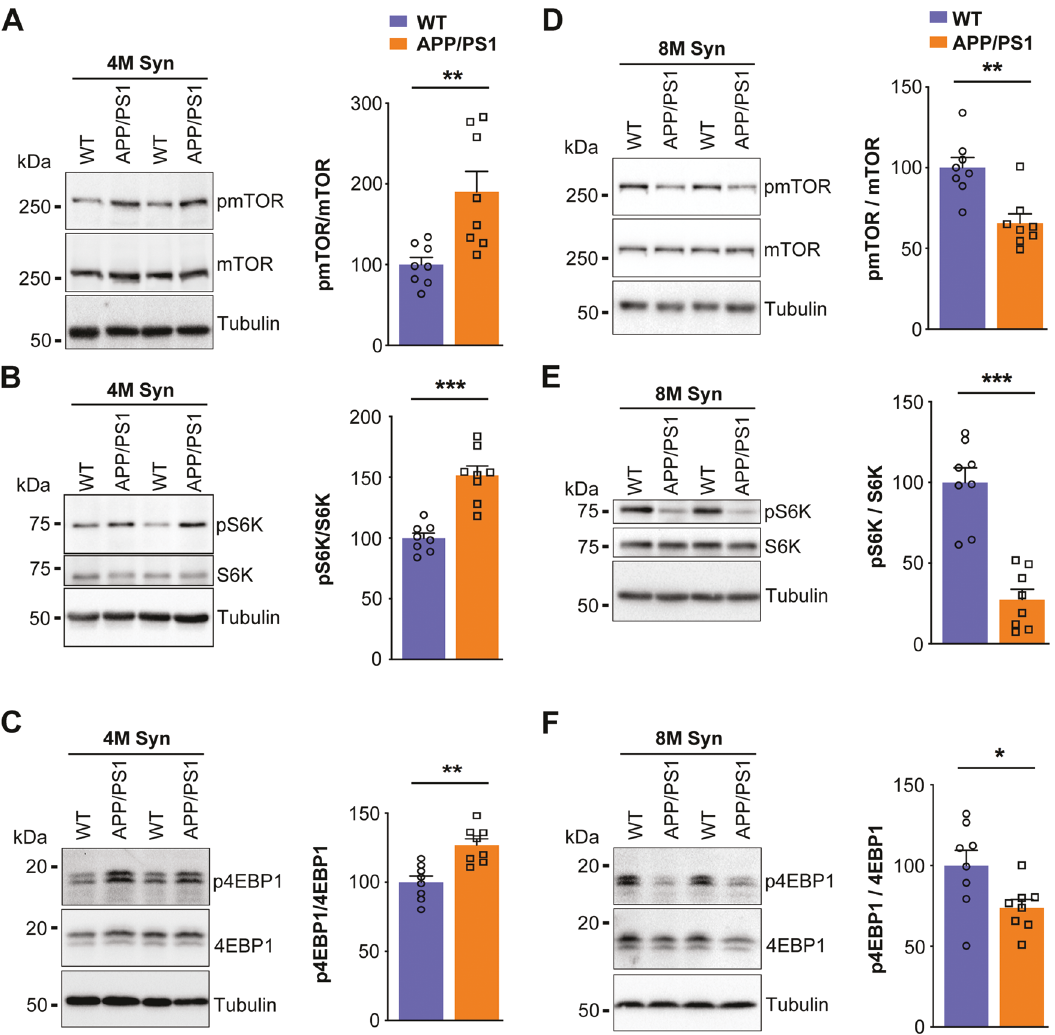
Fig. 4 Phosphorylation of mTOR, p70S6K, and 4E-BP1 is increased in synaptosomes of APP/PS1 female mice at 4 months of age but decreased at 8 months of age. Synaptosomes from the mouse brain cortex of 4 ( A – C ) and 8 ( D – F ) months old WT and APP/PS1 female mice were subjected to western blot analysis for ( A and D ) phospho-mTOR (serine-2448) antibody, ( B and E ) phospho-p70S6K (threonine-389) antibody, and ( C and F ) phospho-4E-BP1 (threonine-37/46). Later, these blots were stripped and reprobed, sequentially, for mTOR, p70S6K, 4E- BP1, and tubulin, respectively. A and D The data were quanti fi ed by measuring phosphorylated mTOR/mTOR (( A ) t = 3.367; df = 14; p = 0.0046; Hedges ’ g (95% CI) 1.59 (0.47, 2.66), ( D ) t = 4.059; df = 14; p = 0.0012; Hedges ’ g (95% CI) − 1.91 ( − 3.06, − 0.73)), ( B and E ) phosphorylated- p70S6K/p70S6K, (( B ) t = 5.908; df = 14; p < 0.0001; Hedges ’ g (95% CI) 2.79 (1.38, 4.15), (E) t = 6.757; df = 14; p < 0.0001; Hedges ’ g (95% CI) − 3.19 ( − 4.66, − 1.67)) and ( C and F ) phosphorylated-4E-BP1/4E-BP1 ((C) t = 4.159; df = 14; p = 0.0010; Hedges ’ g (95% CI) 1.96 (0.77, 3.11), ( F